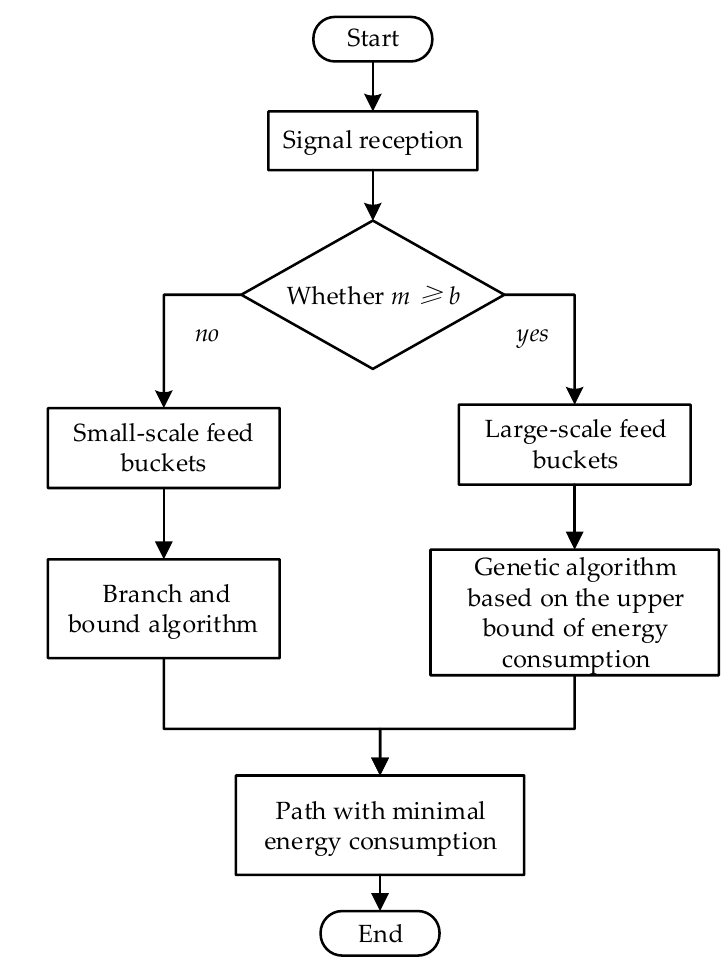
Figure 4. The main flow of the approach in this study.